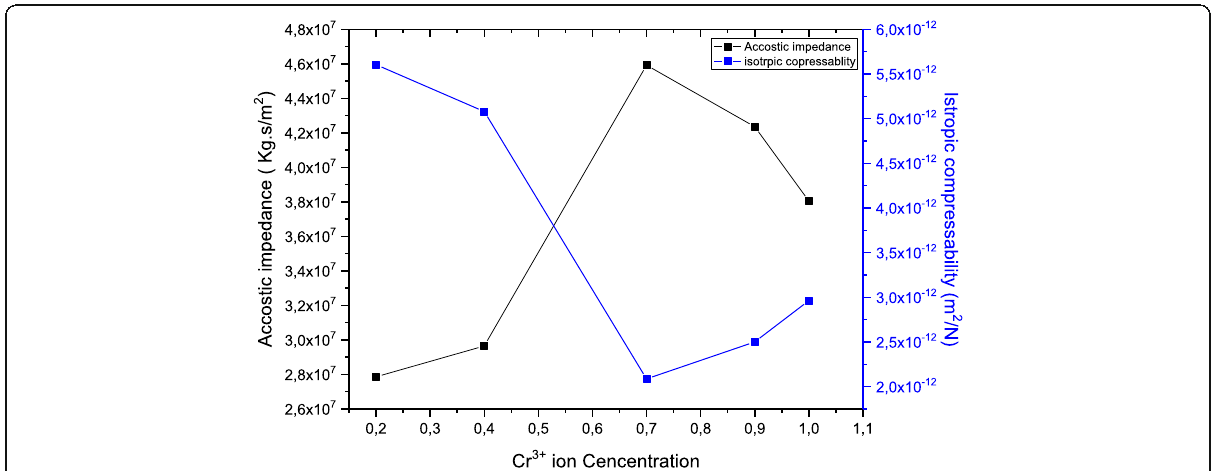
Fig. 4 Variation of the isotropic compressibility and acoustic impedance with varying Cr 3+ ion concentration in Mn-Cr spinel